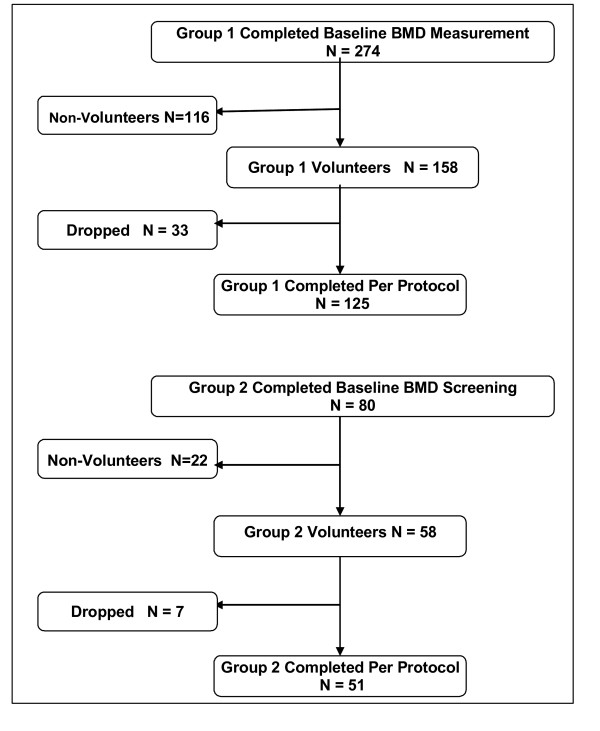
Flow of participants through the trial for both study groups.